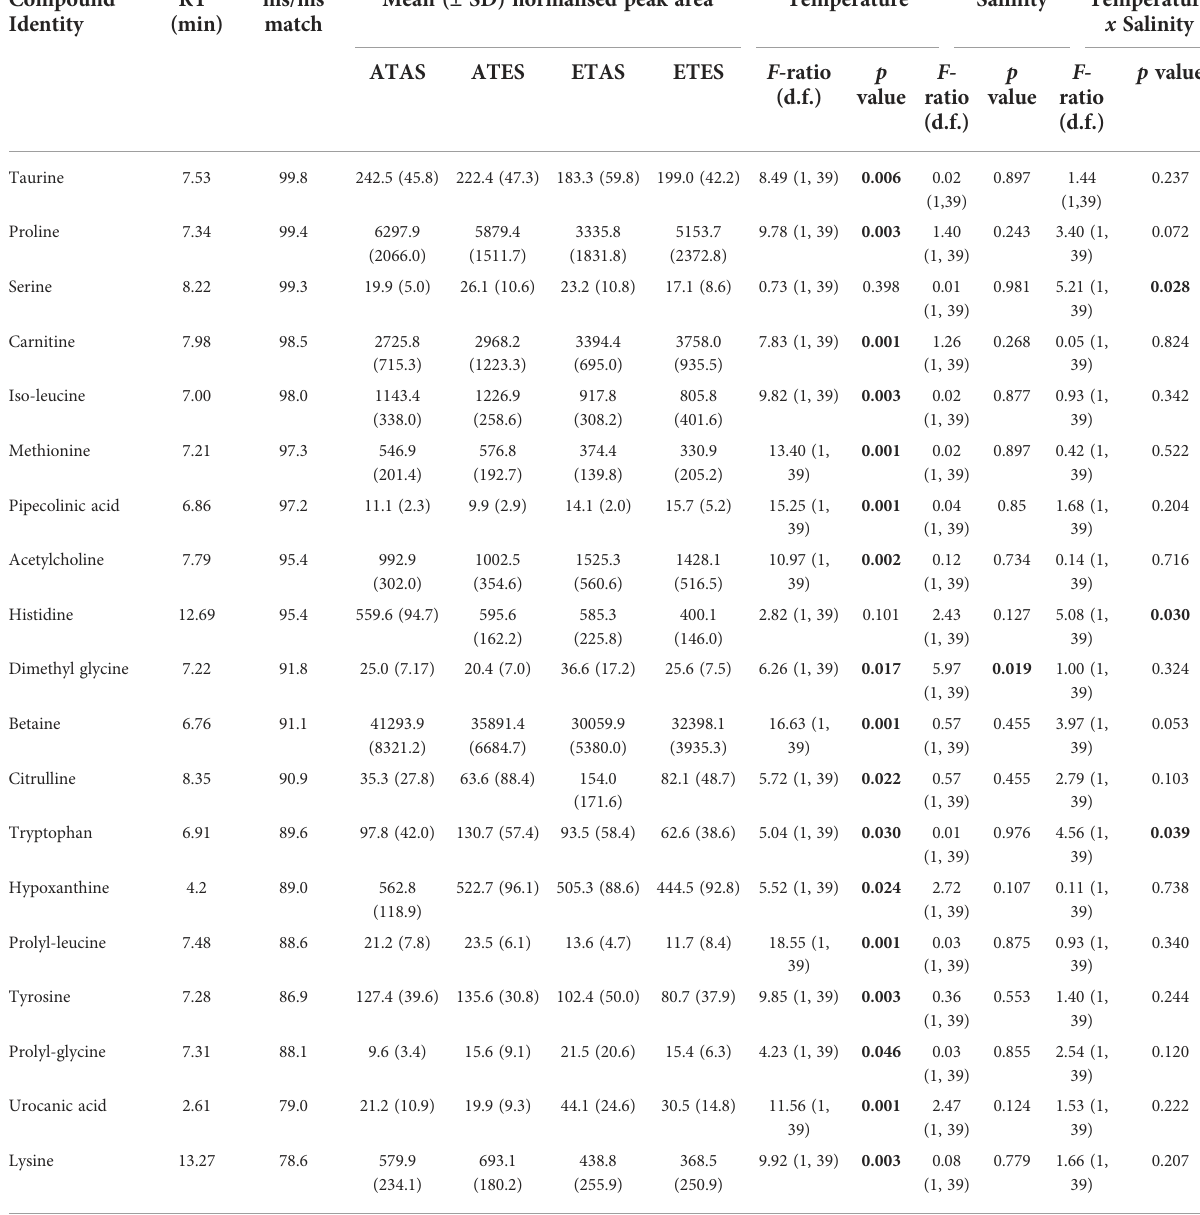
TABLE 2 Non-volatile compounds ( n = 19) positively identi fi ed in the meat of blue swimmer crabs ( Portunus armatus ) that were signi fi cantly (at a = 0.05) affected by temperature or salinity treatments (or their interaction) after 30 days of experimental exposure.